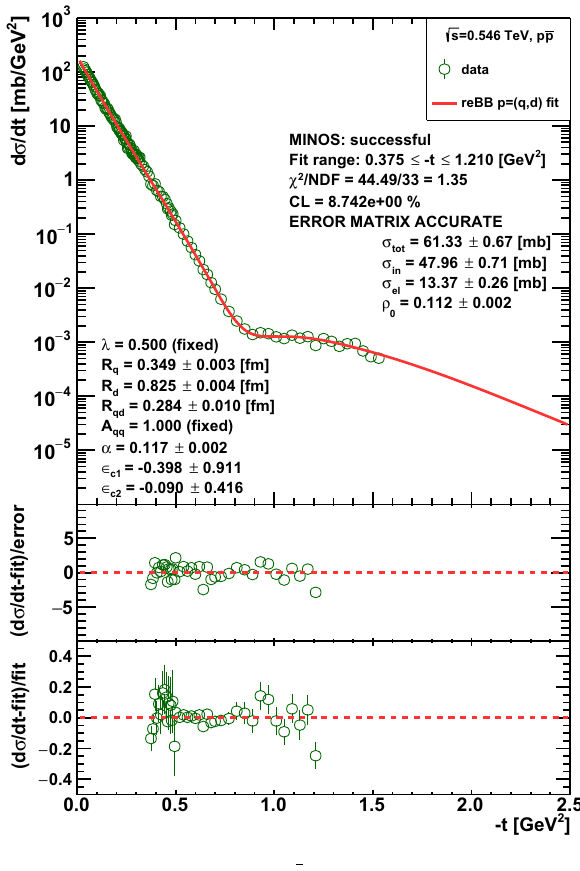
√ Fig. 1 The fit of the ReBB model to the p ¯ p SPS s = 0 . 546 TeV data [48,49] in the range of 0 . 37 ≤ − t ≤ 1 . 2 GeV 2 . The fit includes the published errors, that are statistical (type A) and the normalization (typeC)uncertainties,aswellastheexperimentalvalueofthetotalcross section with its full error according to Eq. (6). The fitted parameters are shown in the left bottom corner and their values are rounded up to three decimal digits. The fit quality parameters and the values of the total, inelastic and elastic cross-sections as well as the value of the ρ 0 parameter are summarized in the top right part of the